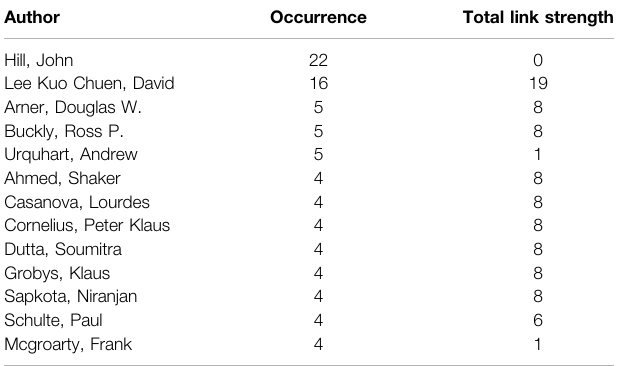
TABLE 3 | Occurrence of authors in the